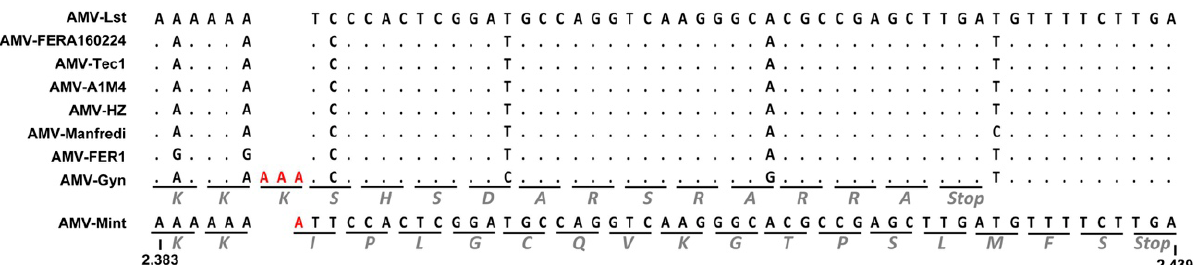
Figure 2. Alignments of partial RNA3 sequences (2,383-2,439 nt for AMV-Mint) showing an insertion of one adenine nucleotide at 2,389 nt of AMV-Mint RNA2, resulting in a reading frame shift mutation in the C-terminal of the AMV-Mint P2 protein. The inserted nucleotides in RNA2 of AMV-Mint and AMV-Gyn are in red. The codons are underlined, and the corresponding amino acids are indicated in italics below the lines.